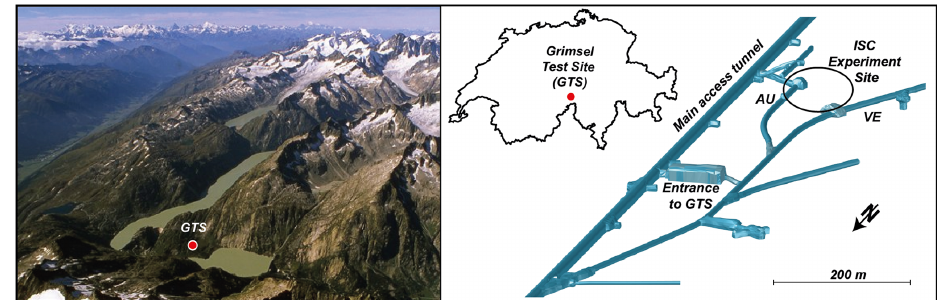
Figure 1. GTS located in the central Alps in Switzerland. The ISC experiment was conducted in the southern part of the GTS, between the VE and the AU tunnels. Figure from Doetsch et al. (2017).